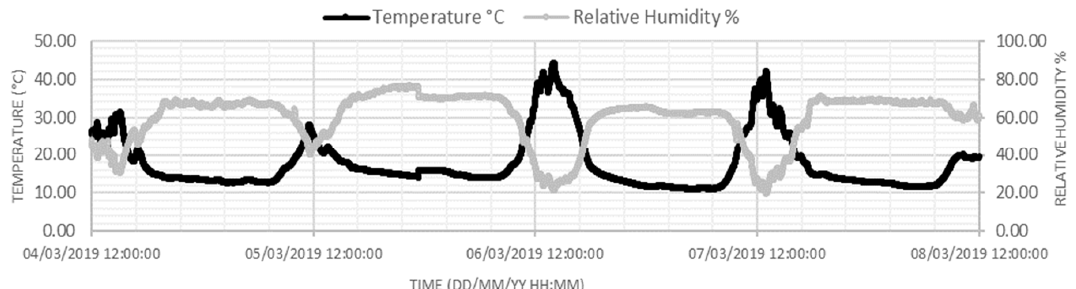
Figure 9. Measured temperature and relative humidity in the first week.